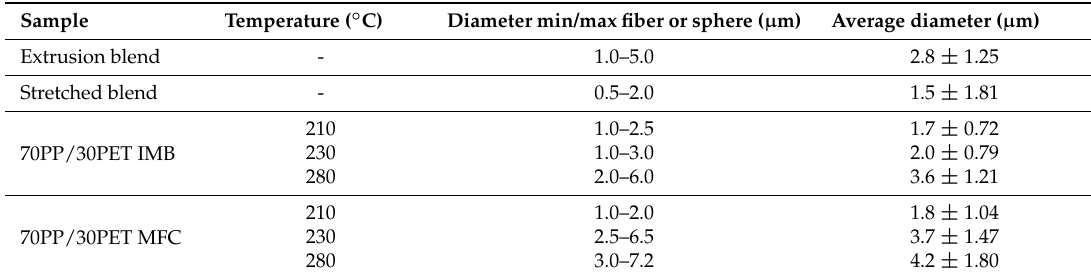
Table 3. Diameters of PET spherical particles and fibers in PP/PET composition.